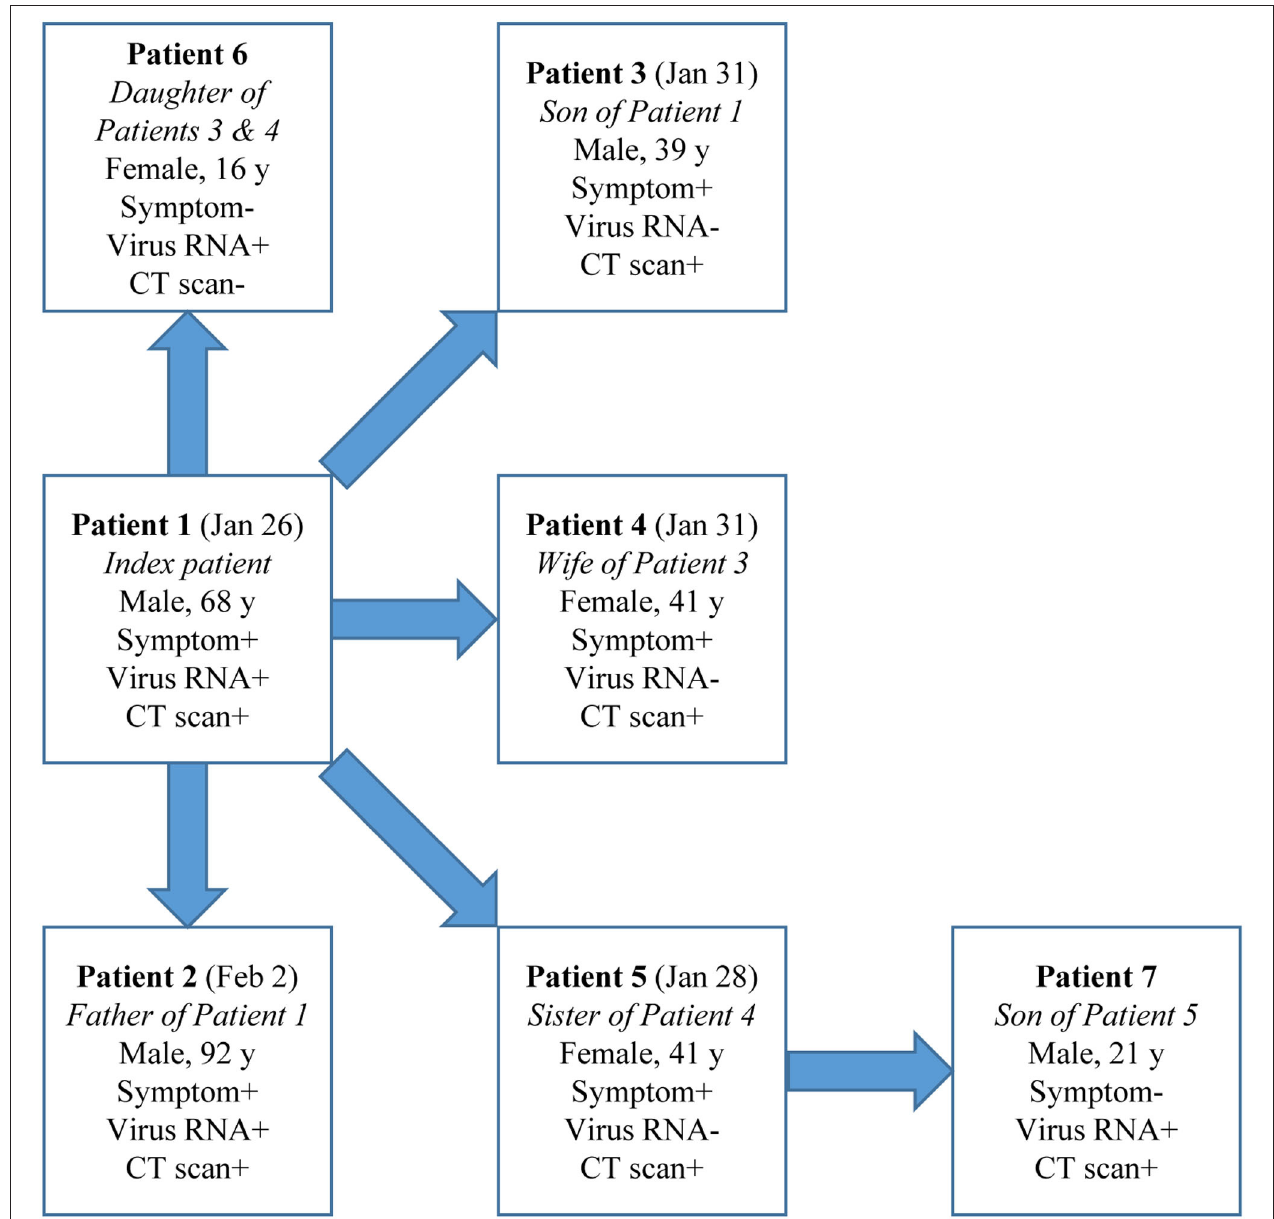
FIGURE 2 | A COVID-19 cluster. Dates are for symptom